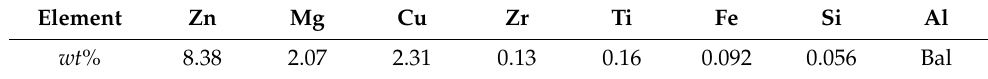
Table 1. Chemical composition of AA 7055 alloy ( wt